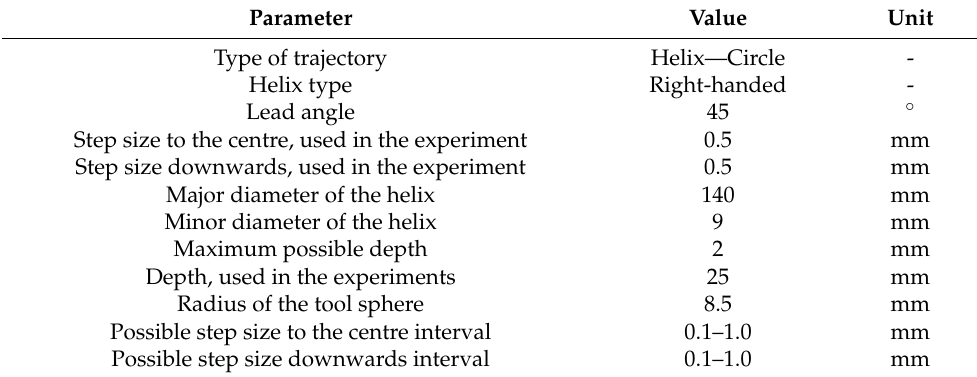
Table 2. Parameters of tool forming path